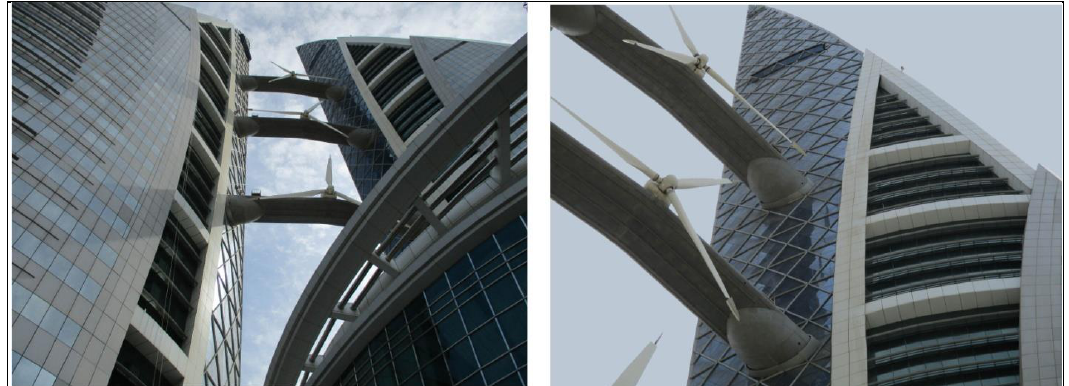
Figure 26. Bahrain World Trade Center: Three wind turbines supported on three different levels by bridges stretched between the towers (photographs by authors).